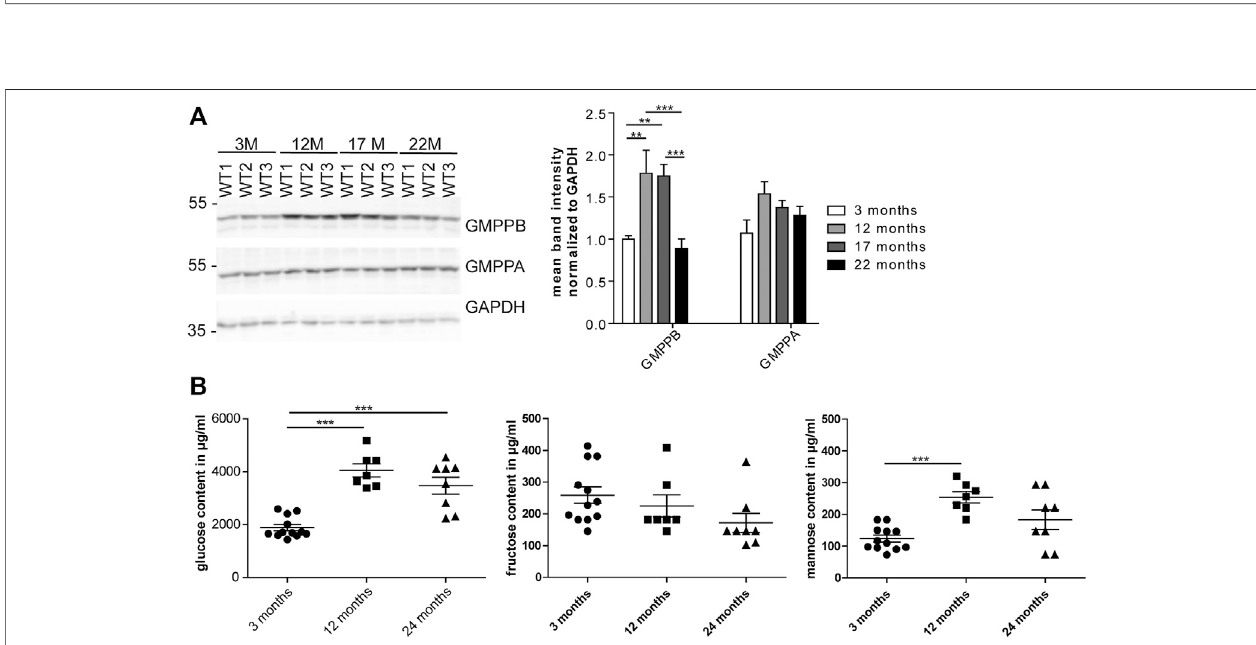
FIGURE2 |WesternBlotsincubatedwithantibodiesrecognizingmannose.Forquanti fi cationGAPDHservedasloadingcontrol( n (cid:2) 6miceperage;2-wayANOVAwith Bonferroni posthoc test). Oligomannose: 6 – 9 terminal mannose residues. Paucimannose: 3 terminal mannose residues. Black brackets indicate measured bands at indicated molecular weights. Quantitative data are presented as mean ± SEM. Individual data points are shown in Supplementary Figure S1